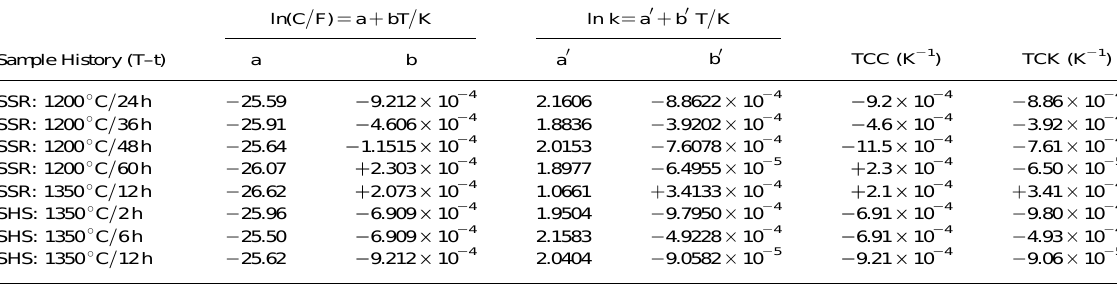
TABLE I Values of TCC and TCK Calculated over the Range 27 (cid:1) –300 (cid:1) C from the Measured Capacitance and Geometry of the SrSnO 3 Ceramic Samples Sintered at Various Temperatures for Different